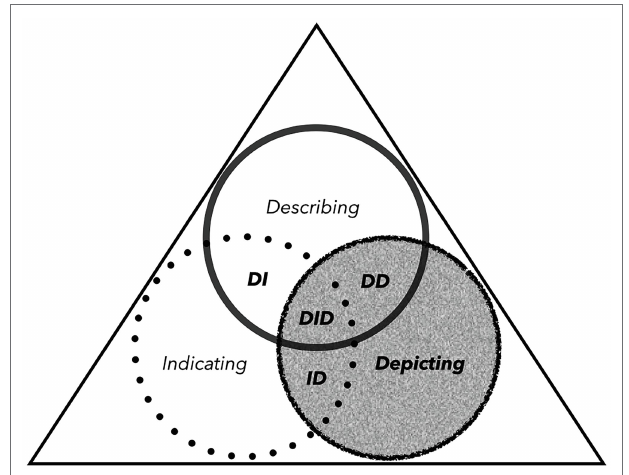
FIGURE 1 | Iconicity (shaded grey) as depicting, indicating, and/or